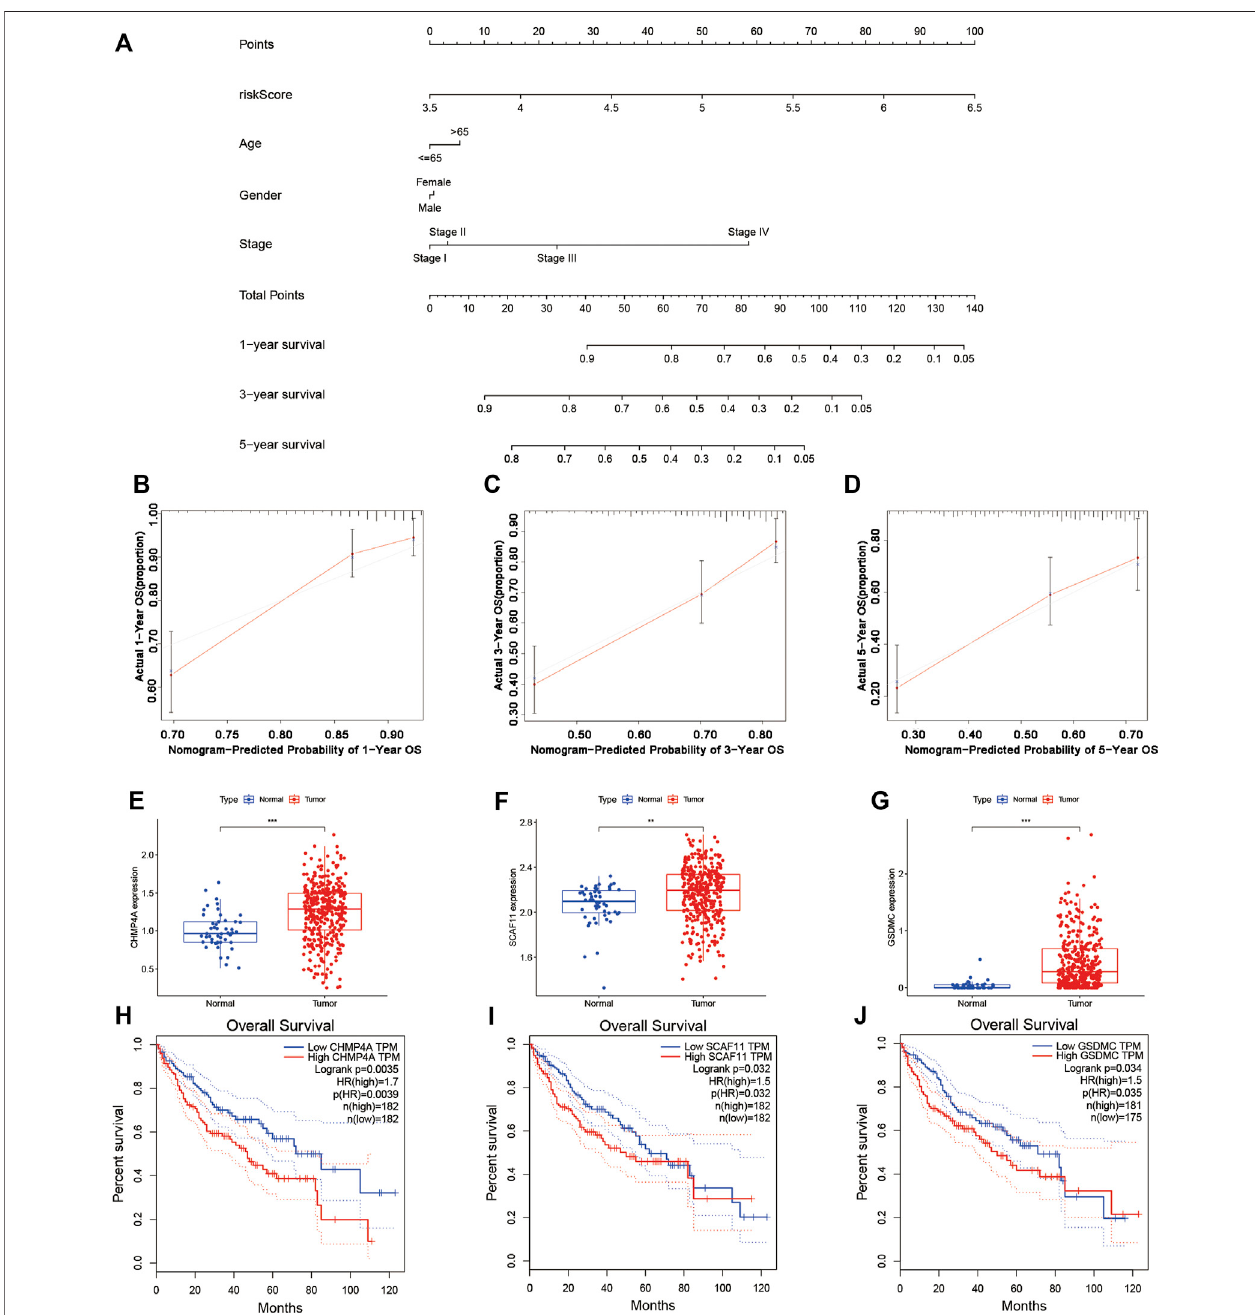
FIGURE 7 | Establishment of the survival prediction nomogram and calibration plot of the nomogram. (A – D) The nomogram and calibration plot in TCGA cohort. (E – G) Analysis of gene expression in the risk model. (H – J) KM survival analysis based on OS in the two subgroups.